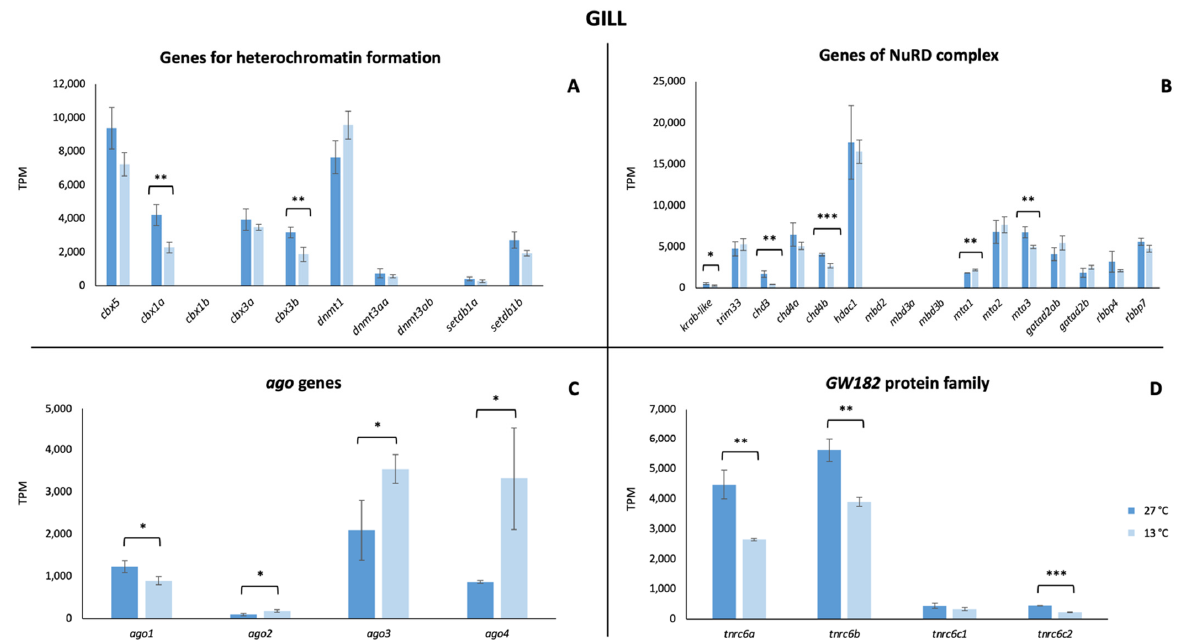
Figure 3. Expression genes involved in TE silencing mechanisms in the gill. ( A ) Expression values of genes encoding for the proteins involved in heterochromatin formation. ( B ) Expression values of genes encoding for proteins forming the NuRD complex. ( C ) Expression values of members of the gene subfamily Argonaute . ( D ) Expression values of genes belonging to the GW182 family proteins. Values are reported for both tested temperature conditions (27 °C and 13 °C). Statistically significant differences are presented as * for p < 0.05, ** for p < 0.01, and *** for p < 0.001.